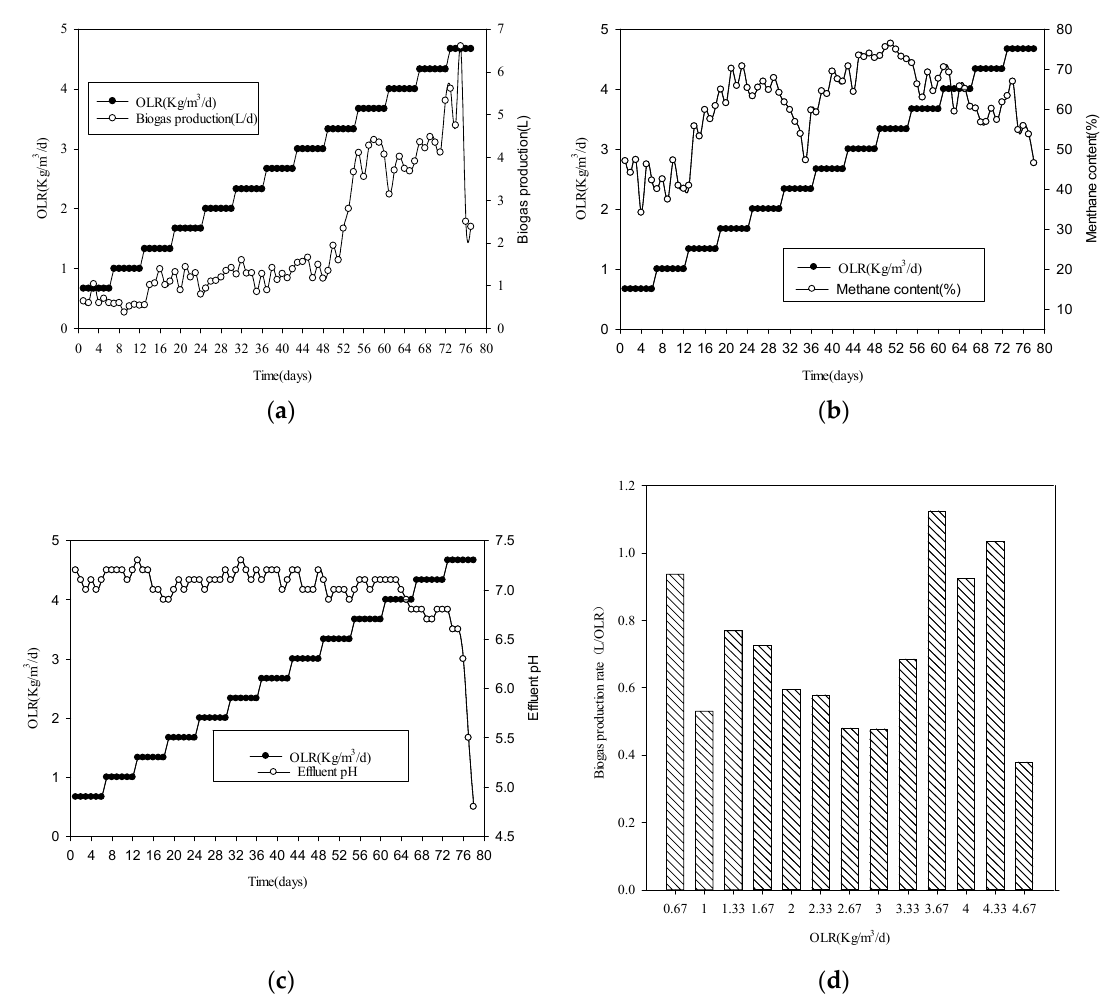
Figure 2. Reactor performance during the entire digestion process. ( a ) Biogas production; ( b ) Methane content; ( c ) Effluent pH; ( d ) Biogas production rate.